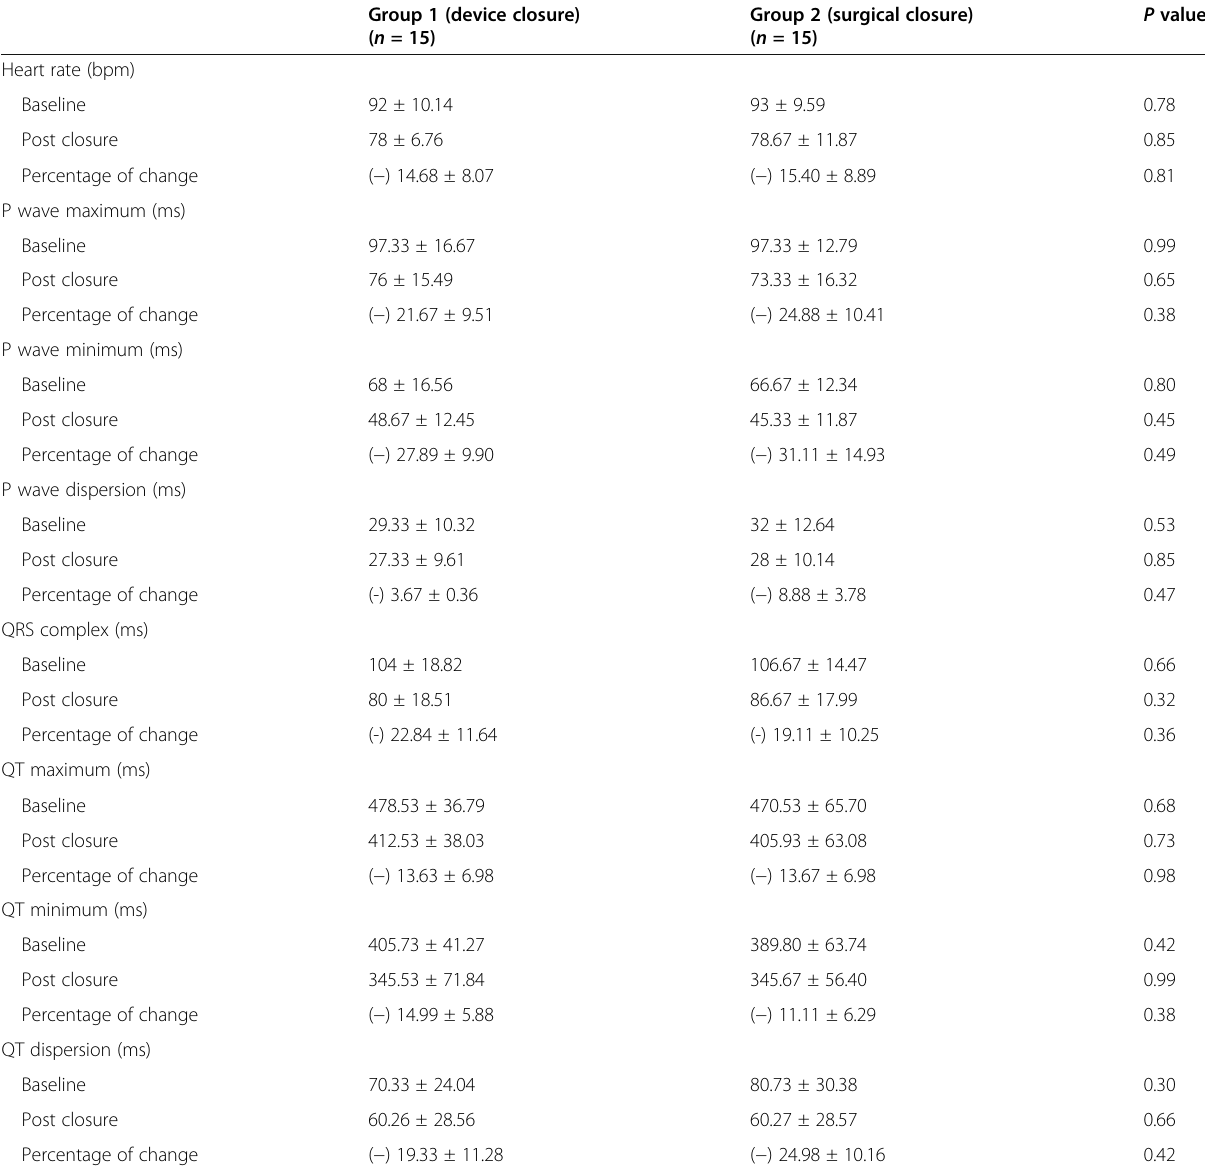
Table 3 ECG parameters comparing both groups